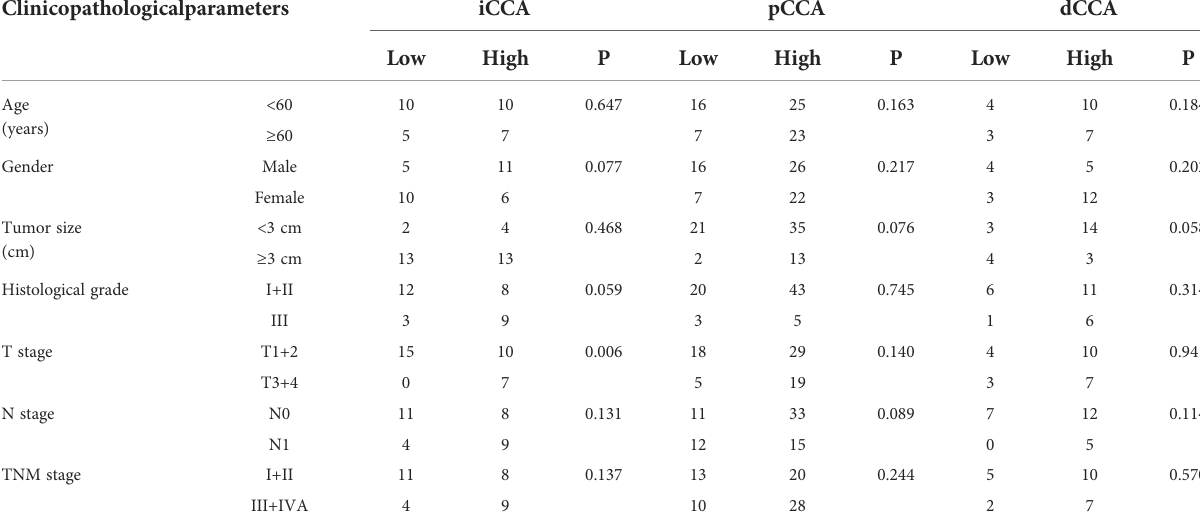
TABLE 2 The correlation between clinicopathological parameters and HJURP expression.